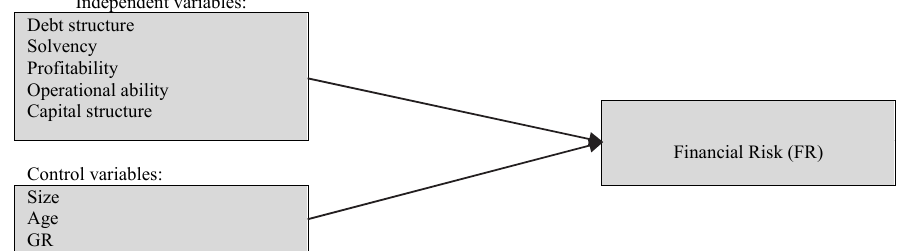
Fig. 1 . Research model of factors affecting firms’ financial